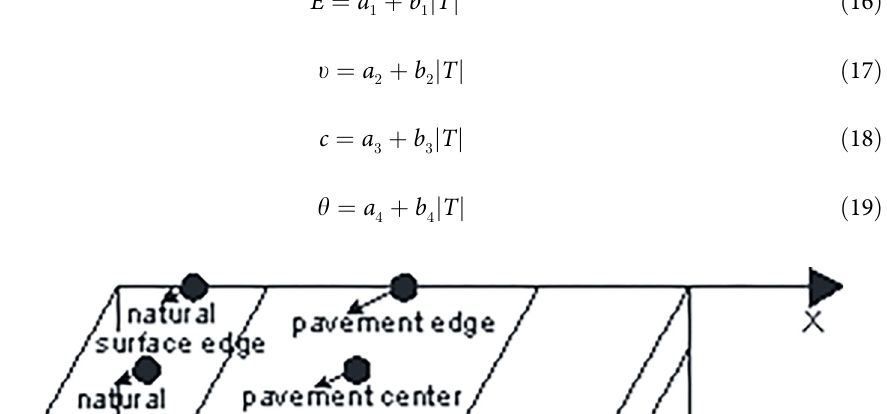
denied any degree of freedom. The edges of the layers of strongly weathered rock, silty clay soil, and clay soil were constrained along the structure’s length and width. The initial temperature field was set to -1˚C [16]. The apparent heat capacity method was used to simulate the phase change that occurred within a certain temperature range. The thermal parameters of the weath- ered rock, silty clay soil, clay soil, and pavement layers are listed in Tables 2 and 3 [33]. A uni- formly distributed rectangular load was applied to simulate the static load of the A380-800 aircraft, arranged symmetrically along the centerline of the upper surface. The Mohr-Coulomb constitutive model was used to characterize the elastoplastic behavior of the strongly weathered rock, silty clay soil, and clay soil. Reference [33] had shown that the mechanical parameters of permafrost were closely related to the temperature, and could be solved by Eqs (16)–(19). The dilatancy angle could be taken as half of the friction angle. The elastic modulus, Poisson’s ratio, cohesion, frictional angle, and dilatancy angle are shown in Table 4. The coefficients of expan- sion of the strongly weathered rock, silty clay soil, and clay soil layers are listed in Table 5 [33]. The mechanical parameters of the pavement structure layers are listed in Tables 6 and 7 [33].